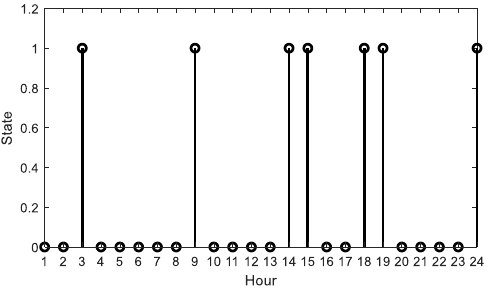
Figure 9. States of connection and disconnection of MG1.